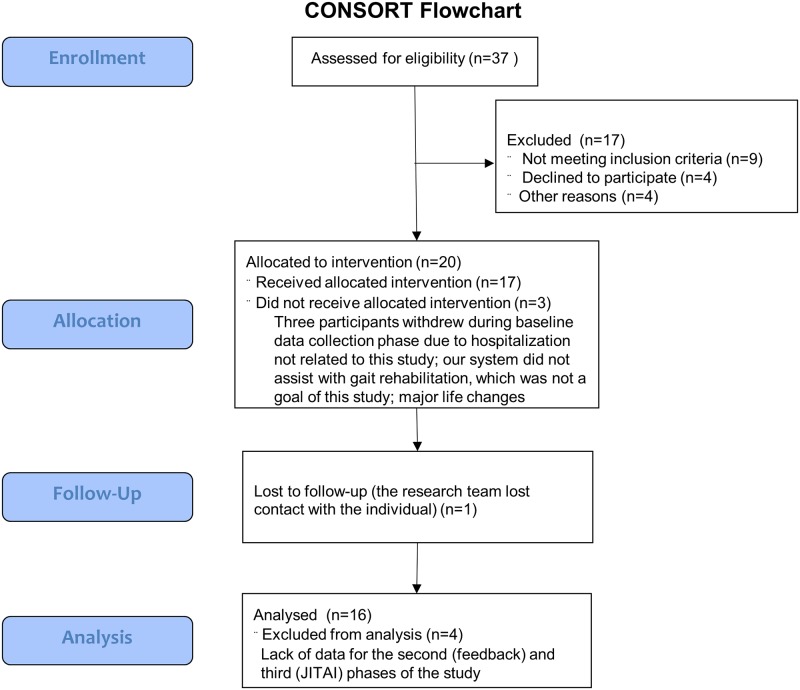
Consort Flowchart.Flow diagram of the progress of participants through the non-randomized pilot study.